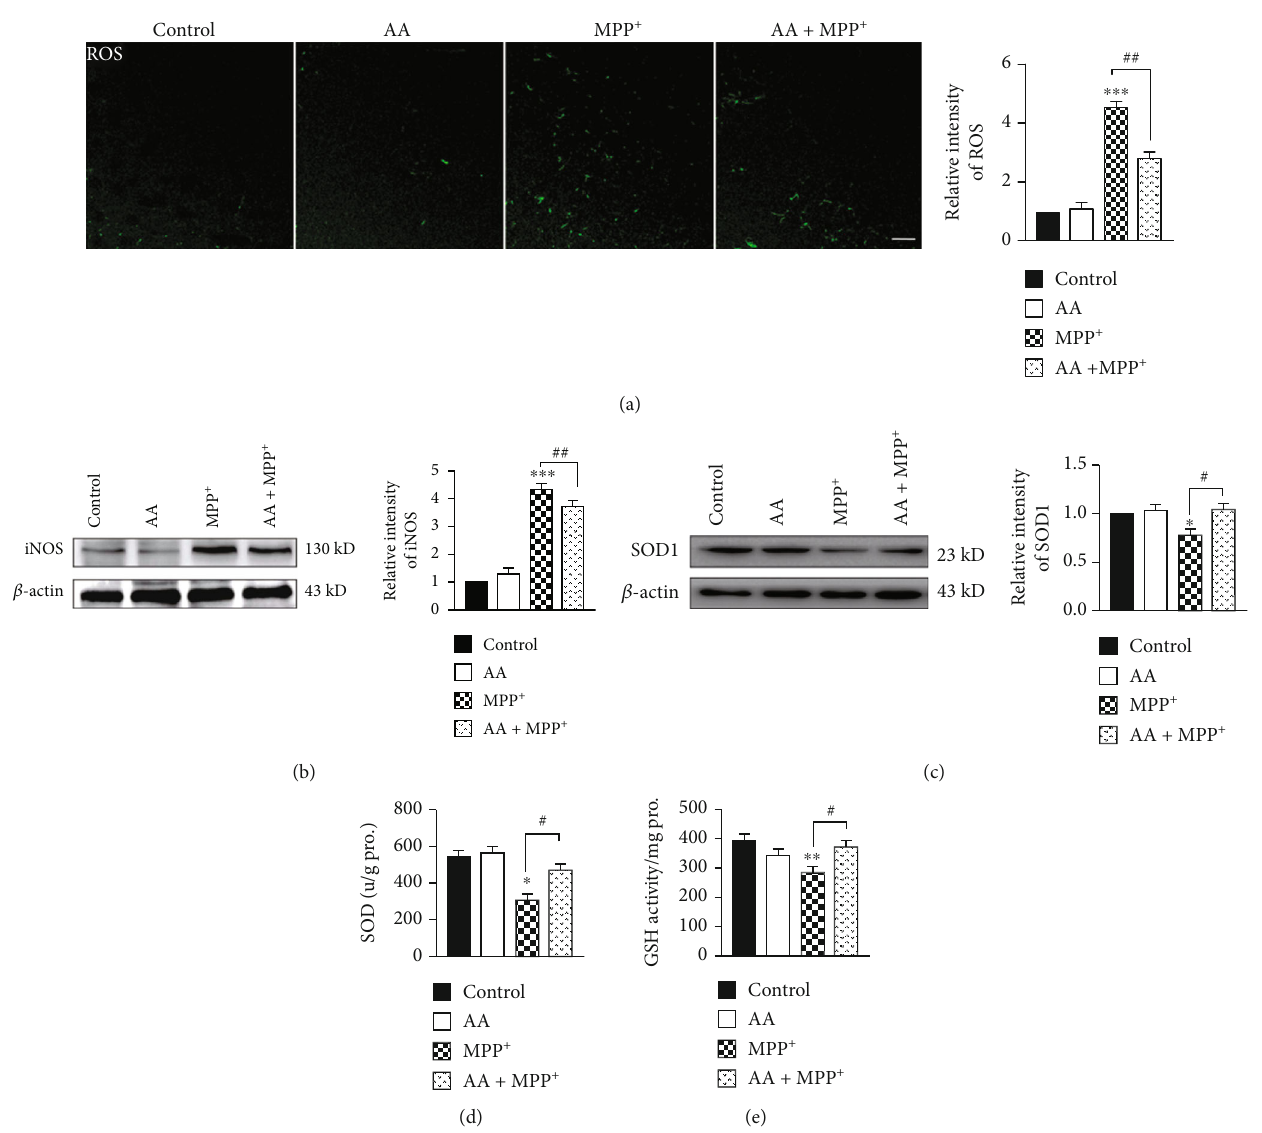
Figure 1: Ascorbic acid reduces MPP + -induced reactive oxygen species (ROS) and inducible nitric oxide synthase (iNOS) production and increases antioxidant expression in astrocytes in vitro . Primary astrocytes were treated with 1 mM of AA for 24h and/or 1 mM of MPP + for another 24h. (a) Intracellular ROS was measured using the carboxy-H2DCFDA method (scale bar, 20 μ m) ( n = 3 ). (b) The expression of iNOS was detected by Western blotting ( n = 3 ). (c) The expression of SOD1 was detected by Western blotting ( n = 3 ). (d) The concentration of SOD in the supernatant from primary astrocytes was detected by ELISAs ( n = 3 ). (e) The concentration of GSH in the supernatant from primary astrocytes was detected by ELISAs ( n = 3 ). Data were obtained from three independent experiments. One-way ANOVAs followed by LSD pairwise comparisons were performed. ∗ was considered signi fi cant compared to control ( ∗ P < 0 : 05 , ∗∗ P < 0 : 01 , and ∗∗∗ P < 0 : 001 ). # was considered signi fi cant compared to MPTP or MPP + ( # P < 0 : 05 , ## P < 0 : 01 , and ### P < 0 : 001